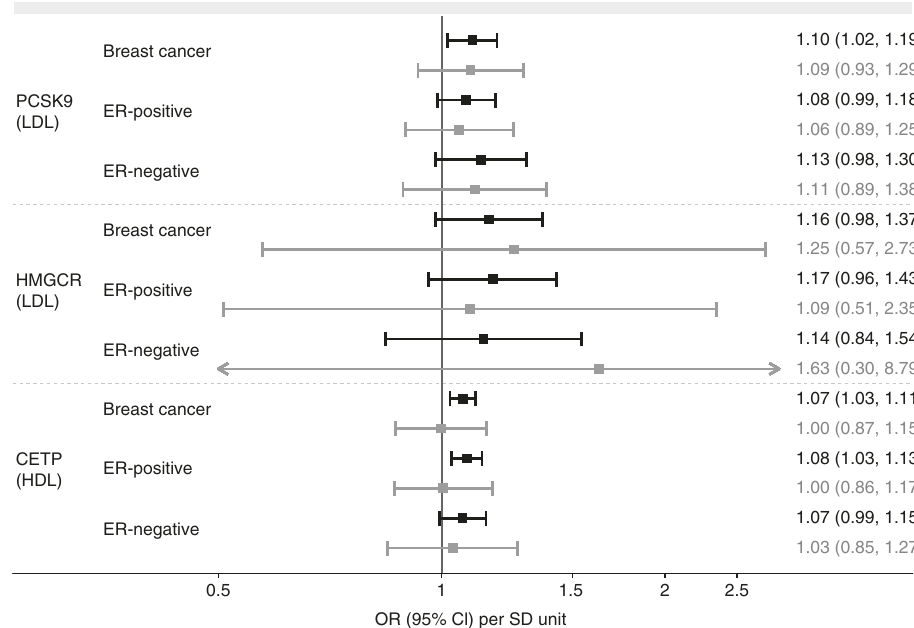
Fig. 3 Causal estimates of blood lipid level-increase due to genetic variants in genes encoding drug targets. Inverse variance-weighted (black) and MR Egger (gray) instrumental variable estimates using genome-wide signi fi cantly associated variants within 100 b either side of the gene in low linkage disequilibrium ( r 2 < 0.4). Analyses take correlations between genetic instruments into account. Causal estimates express the change in odds ratio (OR) per standard deviation (SD) increment in lipid concentration. Error bars indicate 95% con fi dence